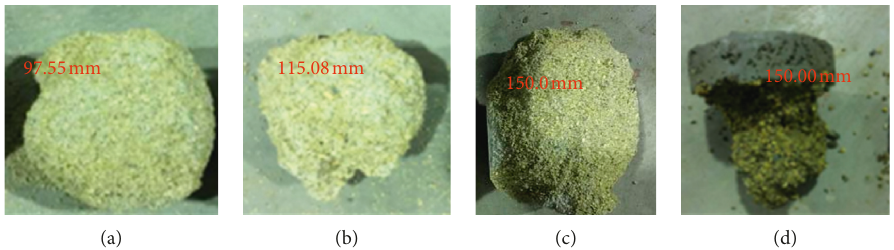
Figure 5: Shape of concretion after sample grouting with different water-cement ratios of soil sample S3. (a) W / C � 0.5. (b) W / C � 0.6. (c) W / C � 0.8. (d) W / C �